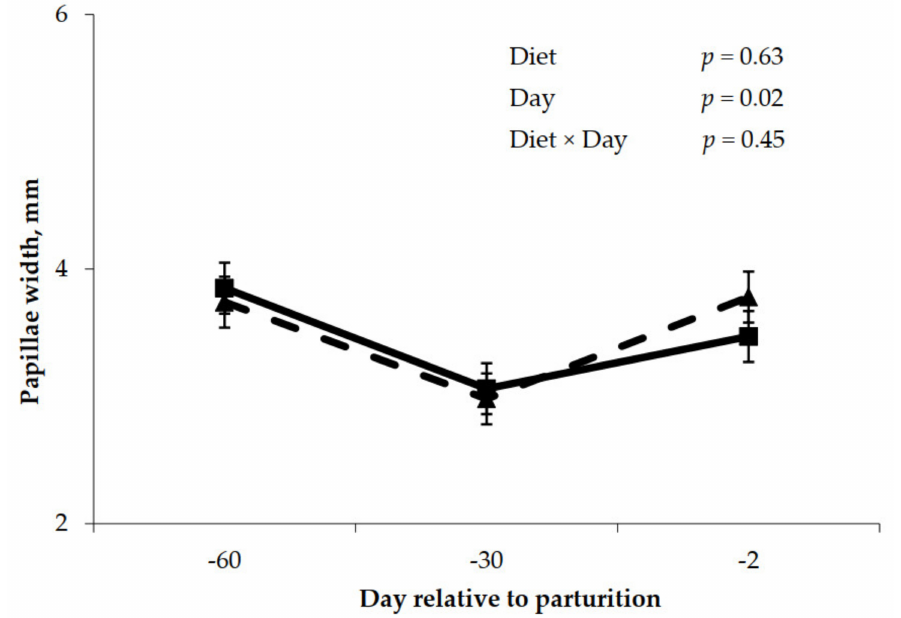
Figure 3. Prepartum papillae width for cows fed control (triangles) or molasses-containing (squares) diets during a 60 day dry period (error bars = pooled standard error of the mean, Experiment 2, n =